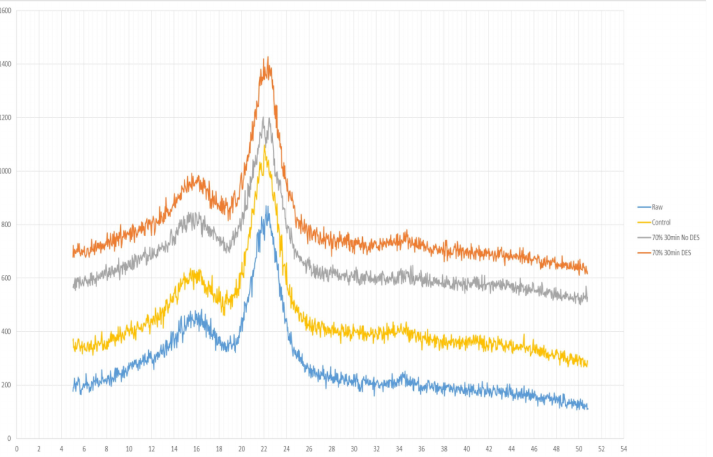
Figure 4. The X-ray diffraction (XRD) spectra of control and pre-treated samples